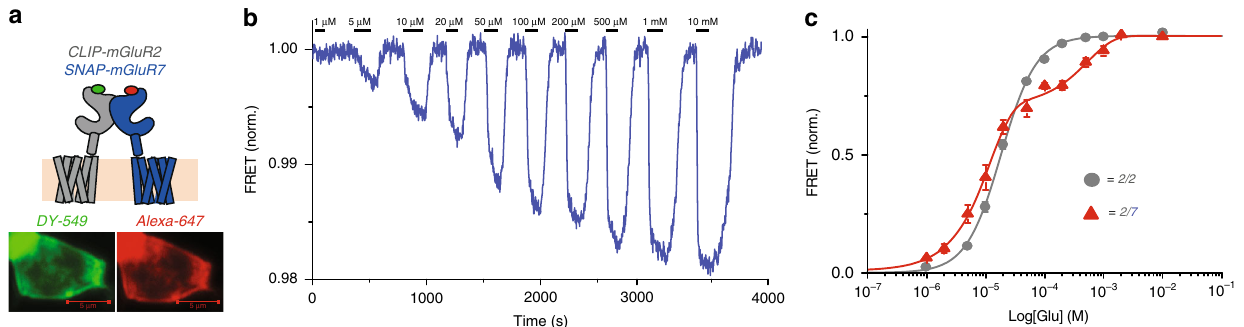
Fig. 3 mGluR2/7 heterodimer has a biphasic glutamate concentration-response in HEK293 cells. a mGluR2/7 heterodimer formed by CLIP-mGluR2 and SNAP-mGluR7 heterodimer. Schematic (top) and images of HEK293 cells (bottom, scale bars 5 µ m) labeled with donor (BC-549) on CLIP-mGluR2 and acceptor (BG-Alexa-647) on SNAP-mGluR7. HEK293 cells expressing SNAP-mGluR7 and CLIP-mGluR2. b Representative live-cell FRET trace of CLIP- mGluR2/SNAP-mGluR7 heterodimers in response to ascending concentrations of glutamate. c Glutamate concentration-response relation of normalized FRET in CLIP-mGluR2/SNAP-mGluR7 heterodimer (red, n = 3, s.e.m. error bars) compared to SNAP-mGluR2/2 (gray, n = 3, s.e.m. rat cortex. We fi nd that we mGluR3 co-precipitates with mGluR7 (Supplementary Fig. 3d). These results suggest that mGluR7 either heterodimerizes with mGluR2 in the hippocampus and with mGluR3 in the cortex, or potentially associates with these proteins indirectly.